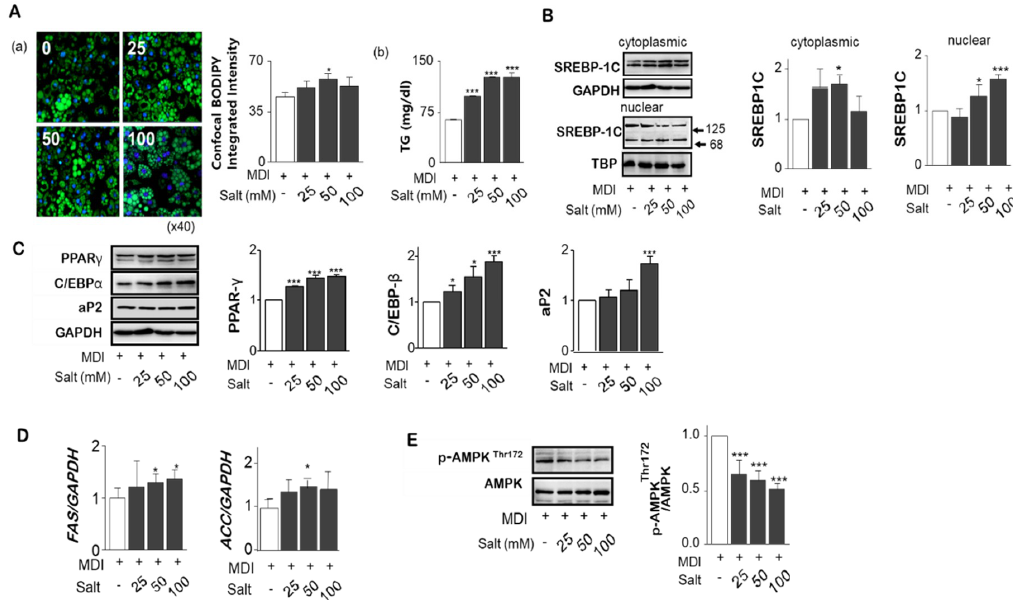
Figure 2. Effect of different levels of salts on TG accumulation, gene expression related to adipogenesis and lipolysis in adipocytes. Using confocal immunofluorescent analysis of 3T3-L1 adipocytes, lipid droplets have been labeled with BODIPY ® 493/503 (green), and fluorescent DNA dye (blue). The fluorescence intensity ratio shows the concentration dependence of salt induced lipid accumulation normalized to the number of cells. ( A-a ) Triglyceride levels in culture supernatant of salt treated 3T3-L1 adipocytes. ( A-b ) The nuclear active form of SREBP-1c was increased, but cytoplasmic SREBP-1c protein was significantly depressed by high salt treatment of 100 mM. ( B ) Protein expression for PPAR ɣ and C/EBPα and transcription factors of aP2 related to adipogenesis were detected by immunoblotting assay. ( C ) Messenger RNA of lipogenesis genes, fatty acid synthase (FAS) and acetyl-CoA carboxylase (ACC), were measured by rt-PCR. ( D ) Total- and phospho-AMPK Thr172 were analyzed by western blotting. ( E ) Data are expressed as mean ± SE of three independent experiments or more. * p < 0.05, ** p < 0.01, *** p < 0.001, significant difference vs